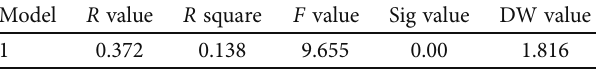
Table 3: Pearson analysis of investor sentiment and investment